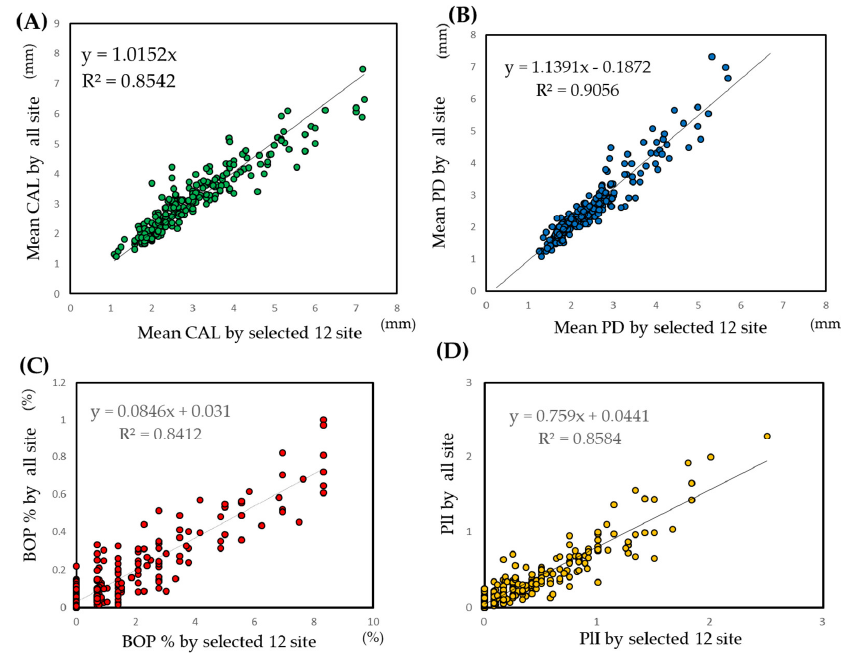
Figure 1. Scatter plot of the mean values of clinical parameters against the mean values of the selected 12 sites. ( A ) CAL: clinical attachment level. ( B ) PD: probing depth. ( C ) BOP: bleeding on probing. ( D ) PlI: plaque index. The selected 12 sites were the same sites that are listed in the Figure 1 legend.